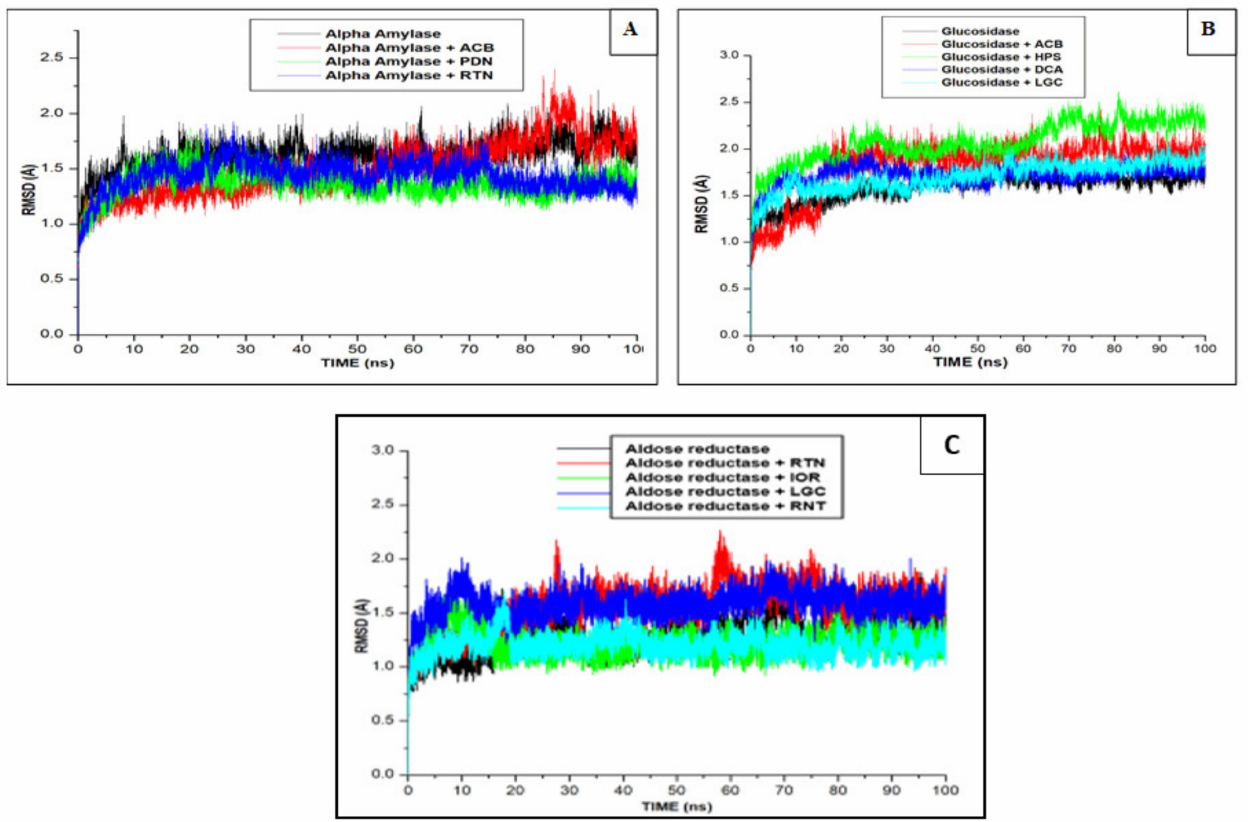
Figure 2. Comparative plots of α -carbon of ( A ) alpha-amylase, ( B ) alpha-glucosidase and ( C ) aldose reductase and phenolic compounds and standard molecules (acarbose, ranirestat) presented as RMSD determined over 100 ns molecular dynamics simulations. ACB: Acarbose; RNT: Ranirestat; PDN: Procyanidin; RTN: Rutin; HPS: Hyperoside; DCA: 1,3-Dicaffeoxyl quinic acid; IOR: Isohamnetin-3- O -rutinoside; LGC: Luteolin7- O -beta- D